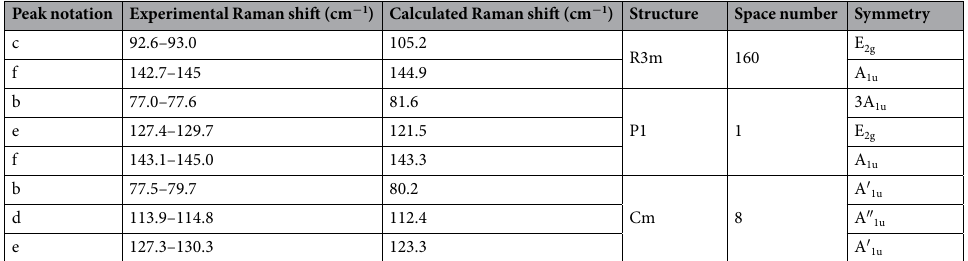
Table 2. Raman peak positions, origins, and